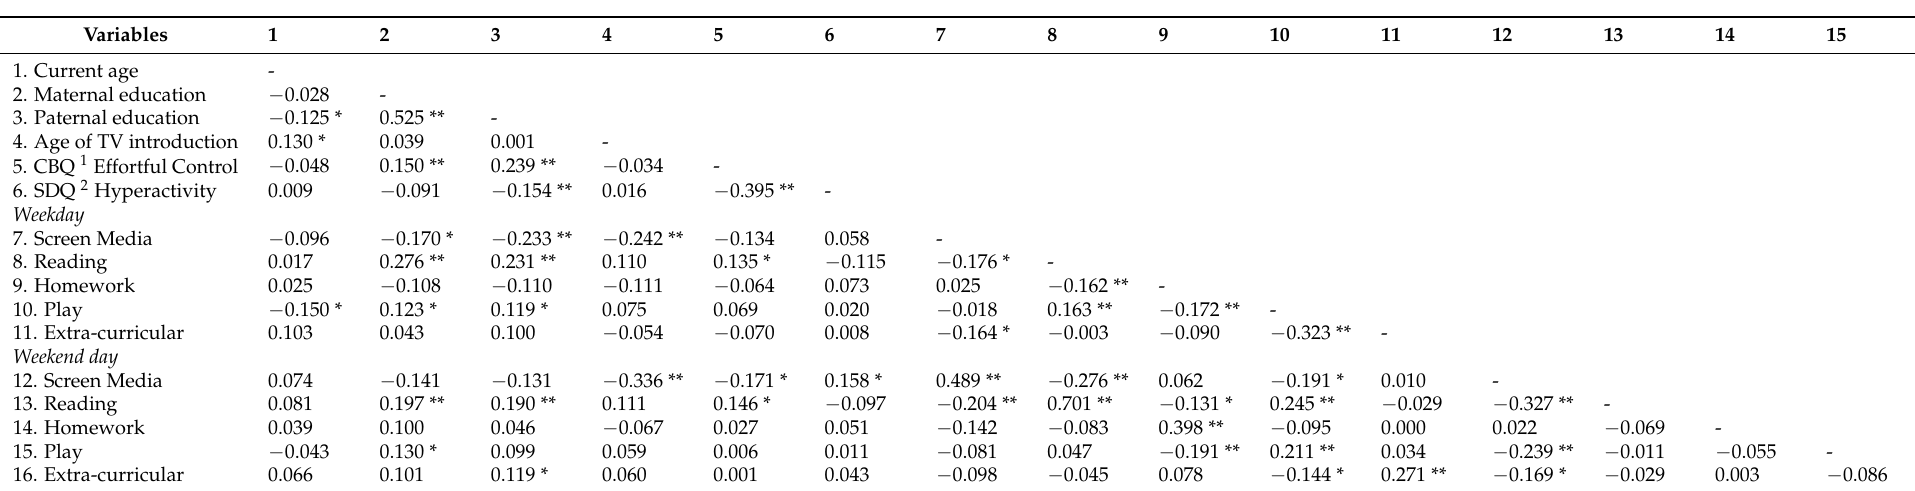
Table 3. Correlations between socio-demographic, behavior, and time-use